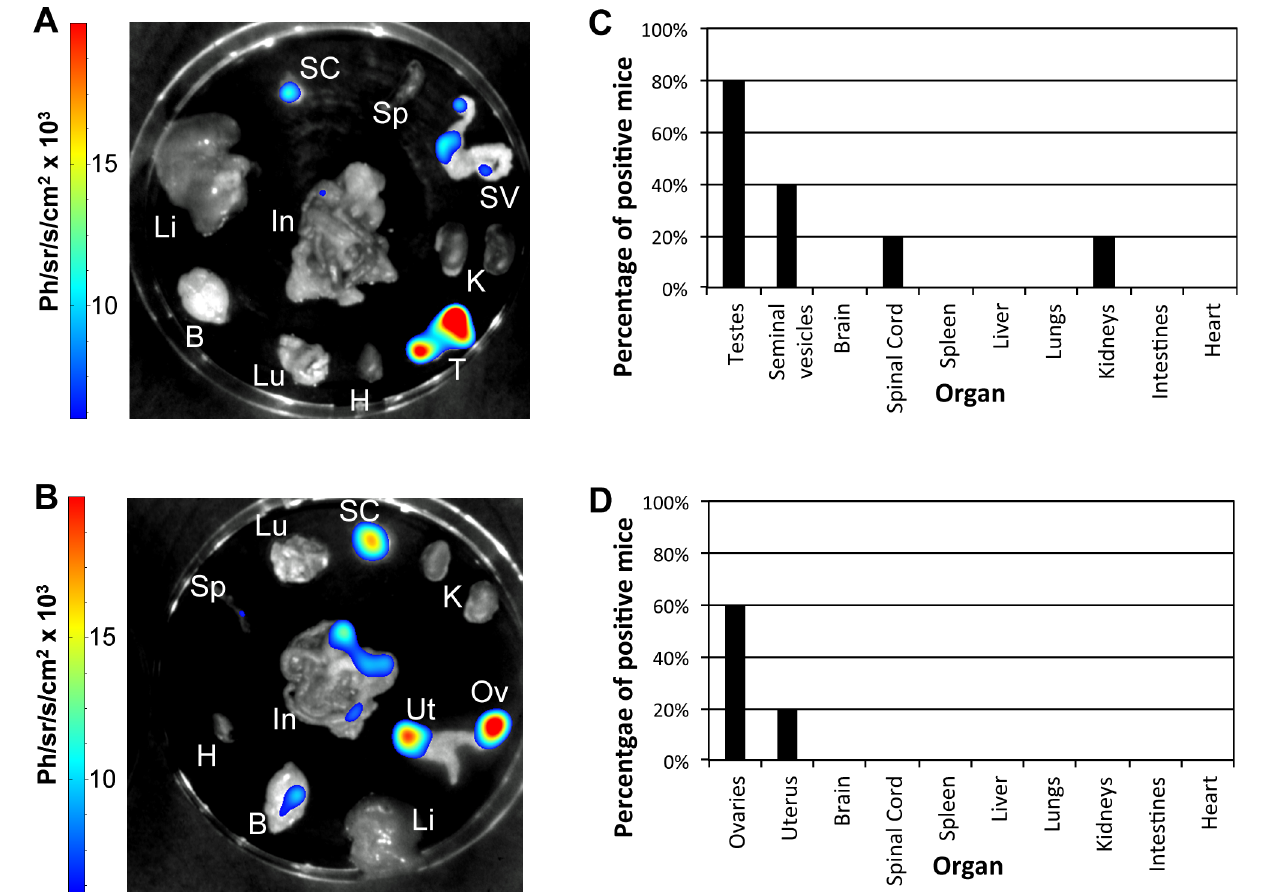
Fig 4. Analysis of vertical transmission by BLI of ex vivo organs of offspring (2 – 3 months old) of T . b . gambiense 1135 (Rluc) infected females (n = 10) crossed with healthy males (n = 5). BLI of ex vivo organs of a representative single (A) male (mouse 32486(1), see S4 Table) and (B) female (mouse 32925 – 1, see S4 Table) offspring. Ov, ovaries; Ut, uterus; T, testes; SV, seminal vesicles; B, brain; SC, spinal cord; Sp, spleen; Li, liver; Lu, lungs; K, kidneys; In, intestines; H, heart. The colour scale to the right of the image indicates the colour intensity in ph/sr/cm 2 /s. Percentage of (C) male and (D) female mice positive by BLI per